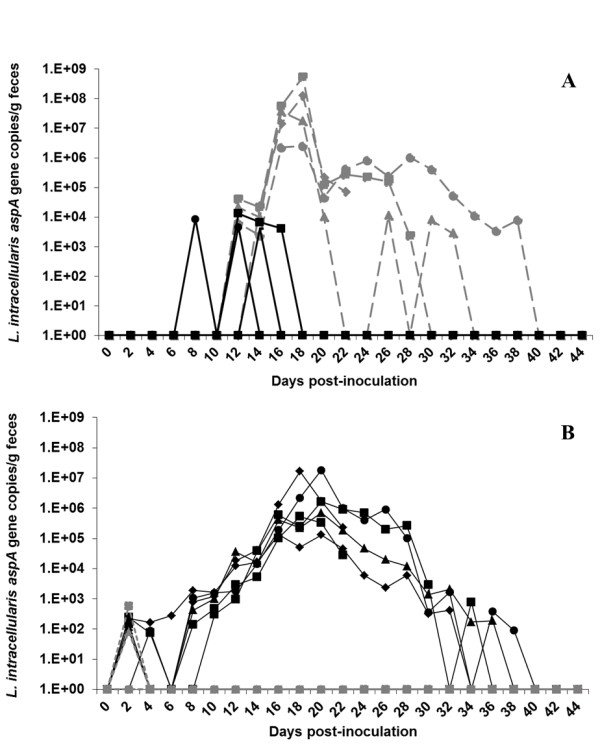
Quantification of the L. intracellularis DNA in the feces performed by qPCR. The results are expressed as copy numbers of aspA gene copies of L. intracellularis per gram of feces throughout the study period. A) Foal experiment. B) Pig experiment. Black-solid lines represent animals infected with the porcine isolate and grey-dashed lines represent animals infected with the equine isolate.